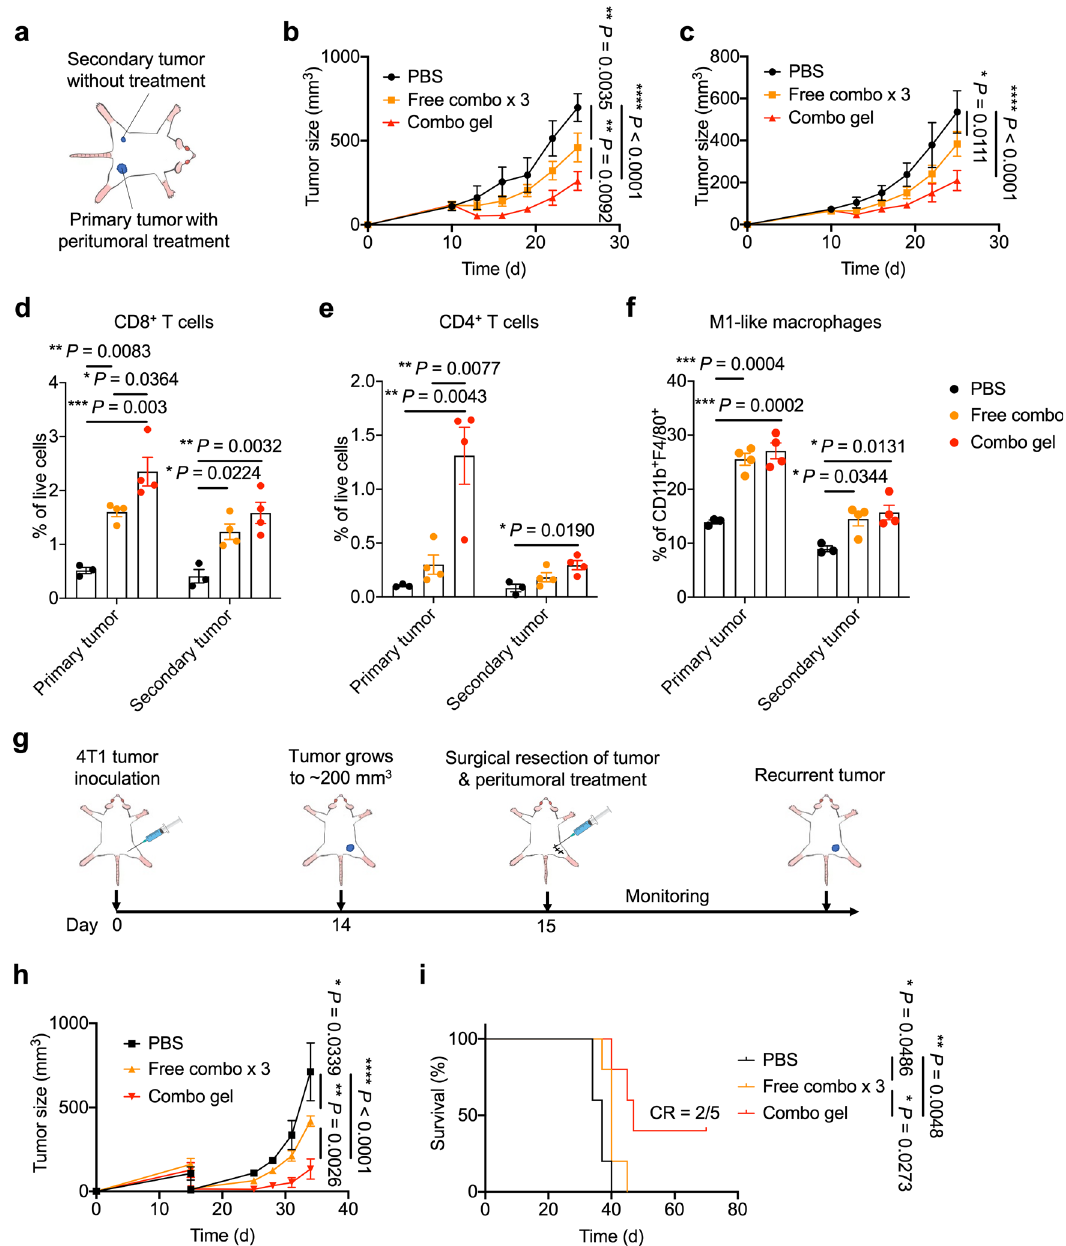
Fig. 5 Hydrogel-assisted local administration of KYNase and Dox induces abscopal effect and inhibits 4T1 tumor recurrence post-surgery. a The experimental scheme. 4T1 cells were injected subcutaneously in both fl anks on day 0. Mice were treated on right fl anks on day 10 with PBS, free KYNase and Dox administered as 3 doses, or KYNase- and Dox-loaded combination hydrogel, when tumor volumes on right fl anks reached 100 mm 3 ( b – f ). b , c Average growth kinetics of primary ( b ) and secondary tumors ( c ), respectively. n = 5 mice per group. d – f Quanti fi cation of CD8 + ( d ) and CD4 + ( e ) TILs, and M1-like macrophages ( f ) in both primary (treated) and secondary (untreated) tumors that were retrieved on day 25. n = 3 mice for PBS and n = 4 mice for the other groups. g The experimental schedule. Mice were inoculated subcutaneously with 4T1 cells on day 0. On day 15, the bulk tumors were surgically removed and mice were treated with PBS, free KYNase and Dox administered as 3 doses, or KYNase- and Dox-loaded combination hydrogel. h Average 4T1 tumor growth over time. n = 5 mice per group. i Survival for all treatment groups with fraction of complete tumor regression (CR). Data are represented as mean ± s.e.m.. Two-way ANOVA with Turkey ’ s post hoc test ( b , c , h ), one-way ANOVA with Turkey ’ s post hoc test ( d – f ) or log- rank (Mantel-Cox) test ( i ) was conducted. Source data are provided as a Source Data fi